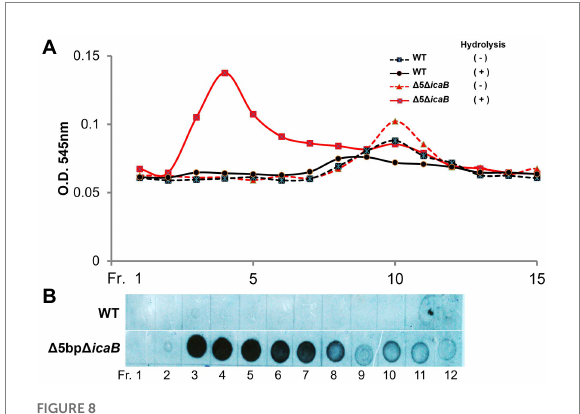
FIGURE 8 Gel permeation high performance liquid chromatography analyses of culture supernatants of FK300 Δ 5bp Δ icaB and WT. Concentrated culture supernatants of FK300 Δ 5bp Δ icaB and FK300 were subjected to gel permeation chromatography (GPC) using Shim-pack Diol-300 (500 × 7.9 mm) under water as the mobile phase with a flow rate 0.5 ml/min. Effluents were fractionated every 2 ml from fraction (Fr.) 1 to 21, 11 min after sample injection. Each fraction, with or without hydrolysis, was analyzed for amino sugar (A) using the Morgan-Elson colorimetric method and the PNAG (B) signal using dot blot with the rabbit anti-PNAG as described in the Methods section. WT; wild type strain